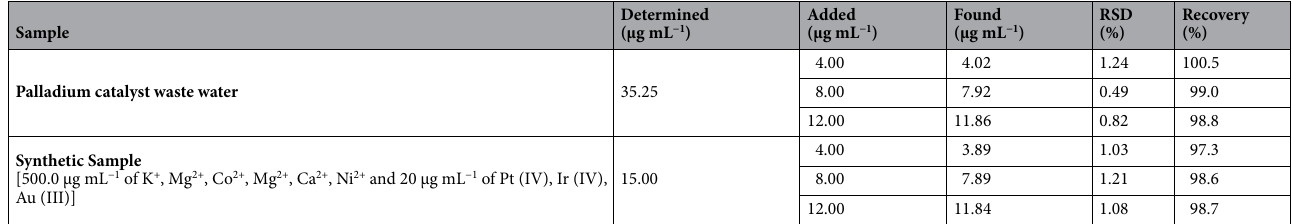
Table 5. Determination of Pd (II) in synthetic sample and palladium catalyst waste water by ICP OES after solvent sublation using 2 × 10 −4 mol l −1 A1, and 2 × 10 −4 mol l −1 HOL, and 5 ml MIBK at pH 4.0. ( n = 5).